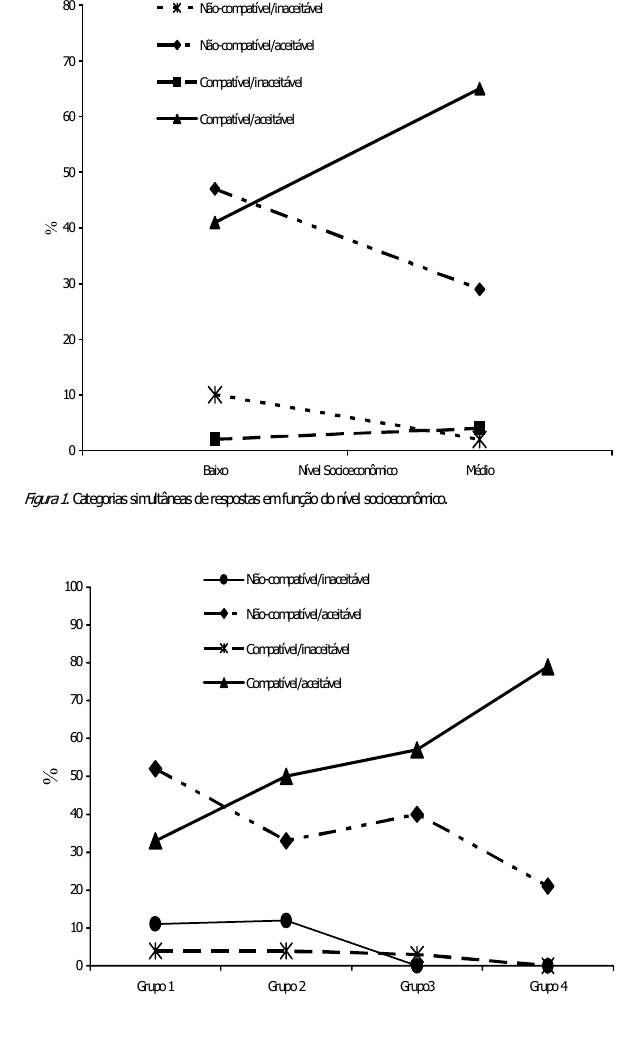
Figura 2. Categorias simultâneas de respostas em função da